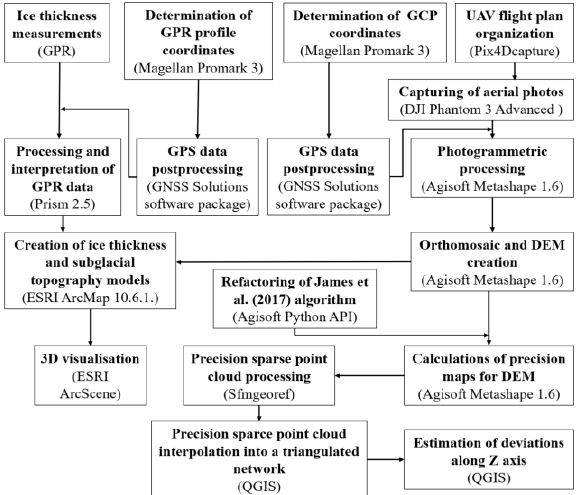
Figure 4. Block diagramm of data gathering and processing